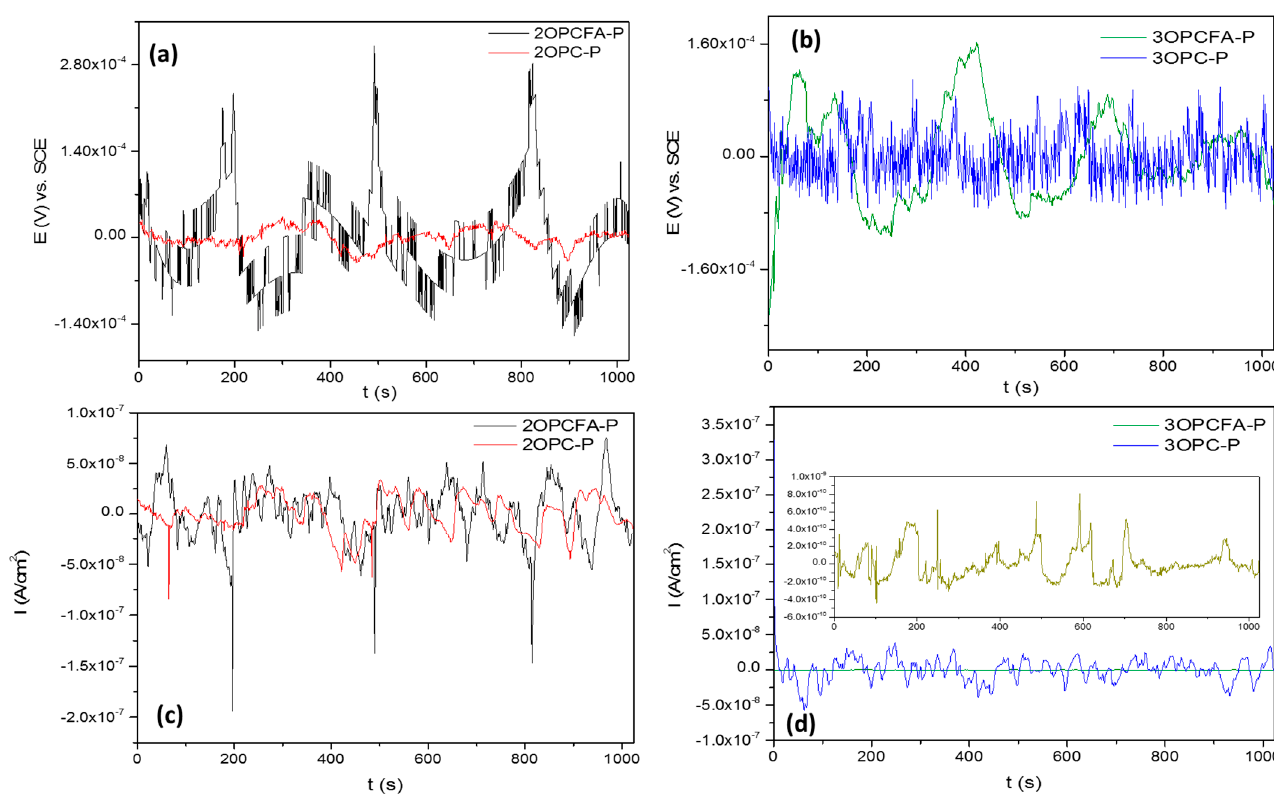
Figure 4. Electrochemical noise-time series for specimens subjected to Impressed current cathodic protection of reinforced concrete mixtures (OPC-P and OPCFA-P). ( a , b ) ENP, 2 and 3 months, ( c , d ) ENC, 2 and 3 months.